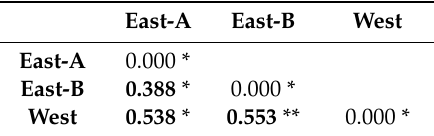
Table 4. Pairwise genetic di ff erentiation ( Φ ST ) among the three lineages based on the chloroplast DNA (cpDNA) sequences of Nitraria tangutorum. * p < 0.05; ** p <